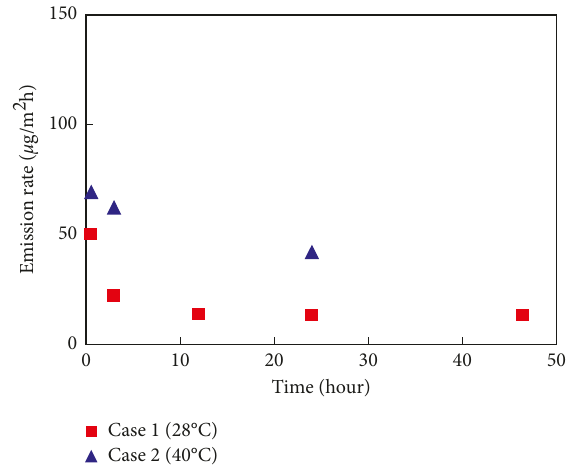
Figure 4: A plot of emission rate versus time showing the emission of di-2-ethylhexyl phthalate (DEHP) from the flooring specimen with regard to the temperature.